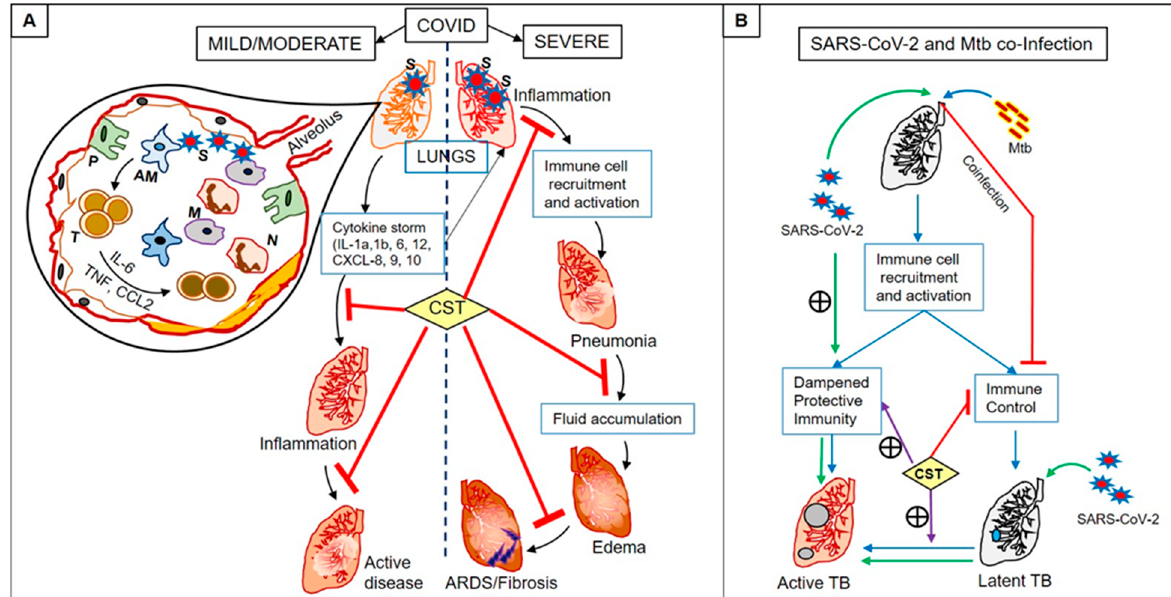
Figure 2. Summary of pathological events associated with Severe Acute Respiratory Syndrome Coronavirus-2 (SARS-CoV-2) and Mycobacterium tuberculosis (Mtb) co-infection and the effect of corticosteroid therapy. ( A ). SARS-CoV-2 enters through the pulmonary route, reaches the alveoli, and interacts with host immune cells, including alveolar macrophages (AM) and pneumocytes (P). Infection of AM produces cytokines/chemokines that recruit and activate other immune cells such as T cells (T), monocytes (M), neutrophils (N) from the blood to the infection site. Activated T cells also produce inflammatory cytokines, leading to a “cytokine storm”. In COVID-19 cases with mild and moderate symptoms, the cytokine storm-mediated inflammation is either controlled and the patient recovers; or the infection progresses to active disease with severe symptoms. The lungs of COVID-19 cases with severe symptoms showed elevated immune cell recruitment and activation, leading to pneumonia. As the disease progresses, the accumulation of fluid in the lungs results in inflammatory pulmonary edema, leading to acute respiratory distress syndrome (ARDS) and pulmonary fibrosis. Corticosteroid (CST) treatment blocks inflammation caused by the cytokine storm and prevents the formation of pneumonia, edema, ARDS, and fibrosis in severe COVID-19 cases. ( B ). Infection of lungs by Mycobacterium tuberculosis (Mtb) causes either symptomatic cavitary progressive tuberculosis (active TB) in individuals with dampened protective immunity or non-progressive LTBI (blue lines) in those with strong immune control. LTBI cases can reactivate to symptomatic TB upon immune-suppressing host conditions. The SARS-CoV-2 infection would happen either in the context of active TB or LTBI (no symptoms). In the SARS-CoV-2 and Mtb co-infected cases (green lines), the host protective immunity is further dampened, leading to exacerbated disease among active TB cases. Besides, SARS-CoV-2 infection of LTBI cases may result in reactivation to active TB (green lines). Corticosteroid (CST) therapy can potentially cause immune-suppression (red line), which augments the dampened protective immunity (purple line), accelerating disease pathology in active TB cases (green line) and reactivates LTBI into symptomatic TB (purple line). Mtb-mediated disease pathologies can be further worsened by SARS-CoV-2 infection; thus, both TB and SARS-CoV-2 promote the disease caused by each of these pathogens.